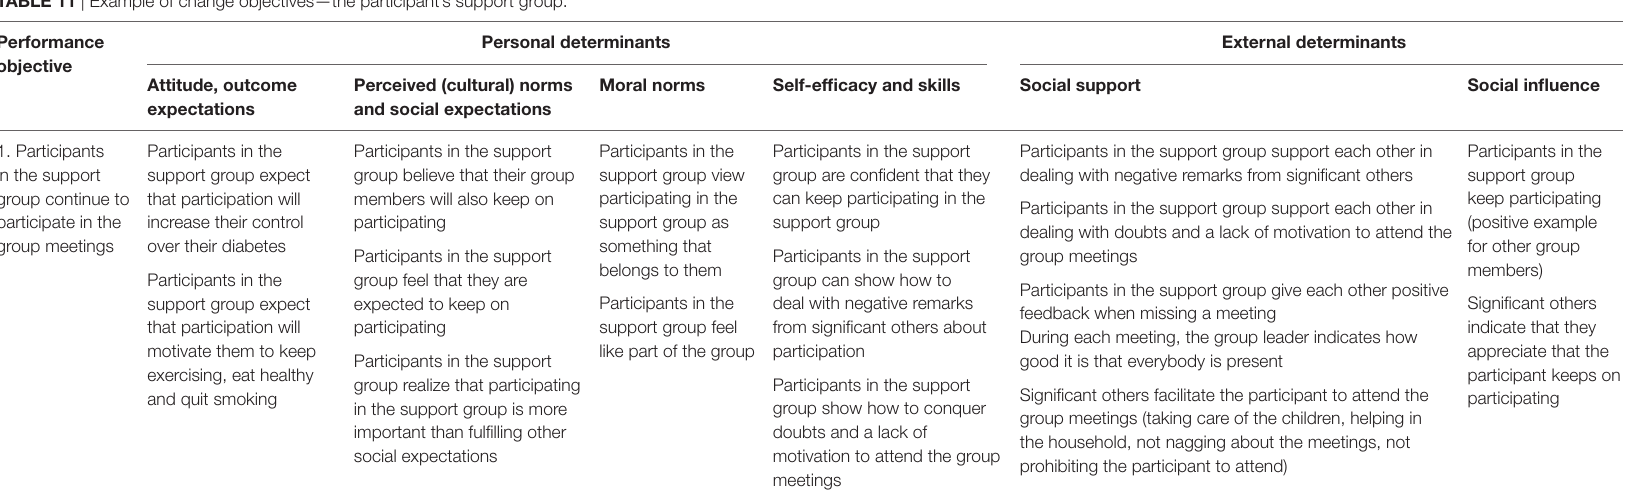
TaBle 11 | Example of change objectives—the participant’s support